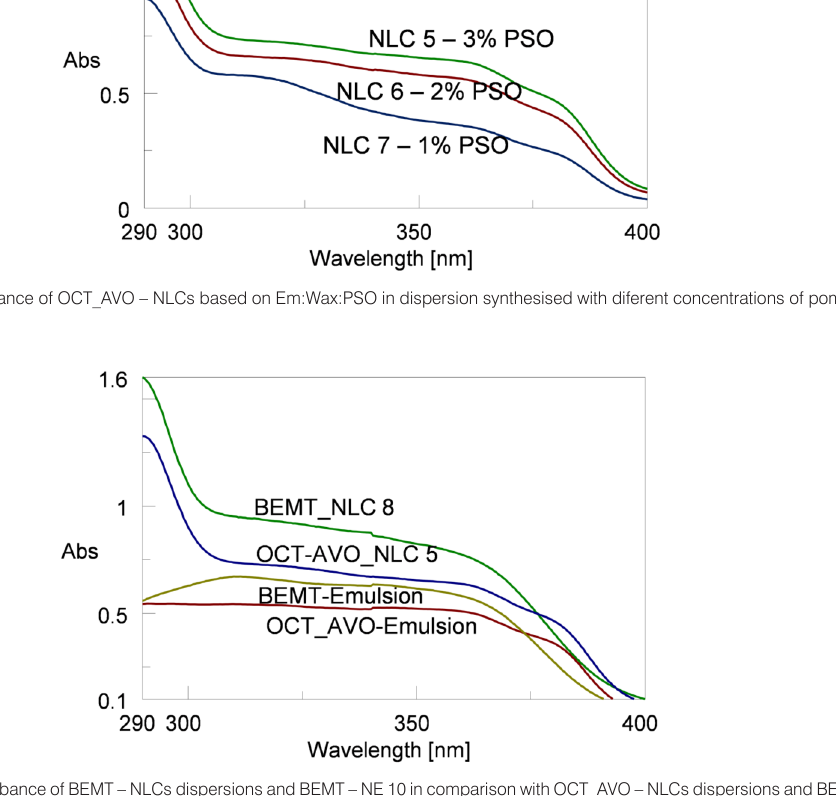
Table 4 . For all UV filters, the data best fits the Peppas-